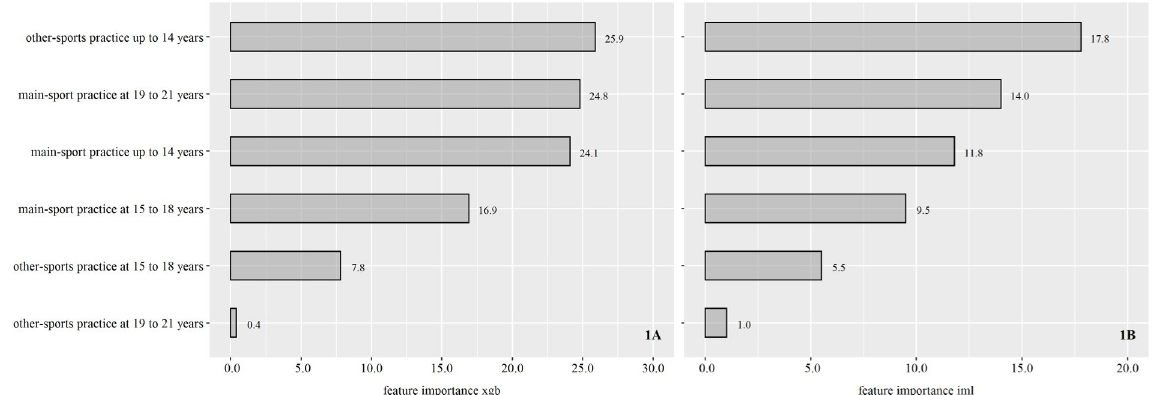
Fig 1. Importance of the model’s features. Note : A: Each variable’s relative contribution is scaled with the sum of all adding to 100. B: Ratio between “permutation error” and “original error” was calculated, which means features with an importance of (around) 1 are not relevant for the